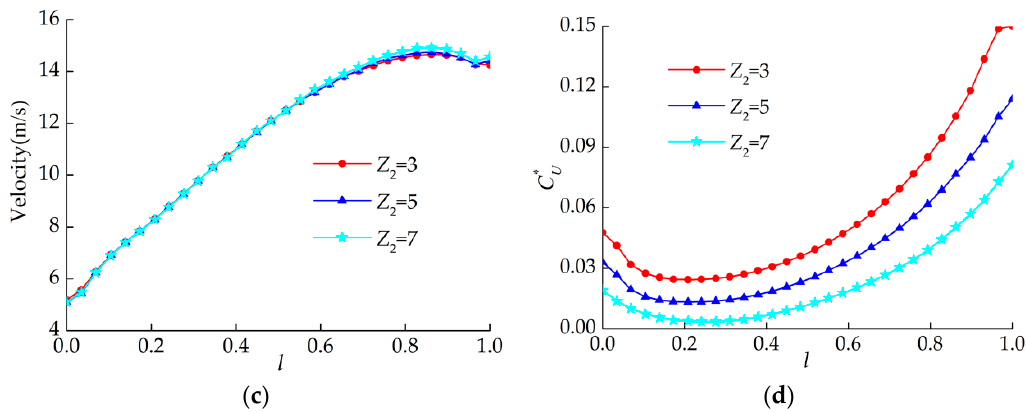
Figure 10. The time-average and the fluctuation intensity curves of pressure and velocity on the blade surface of the impeller with different numbers of guide vanes. ( a ) The curves of the pressure time-average; ( b ) the curves of pressure fluctuation intensity; ( c ) the curves of the velocity time-average; ( d ) the curves of velocity fluctuation intensity.